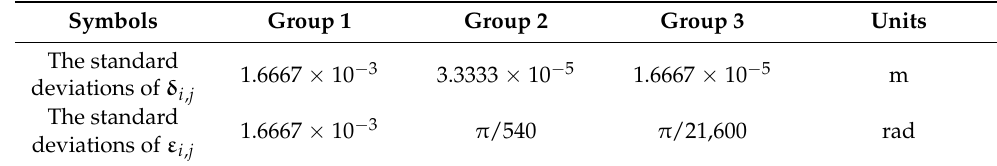
Figure 6. 1738 target poses of the 2UPR-RPU parallel manipulator. Table 8. Standard deviations of the geometric errors for the numerical